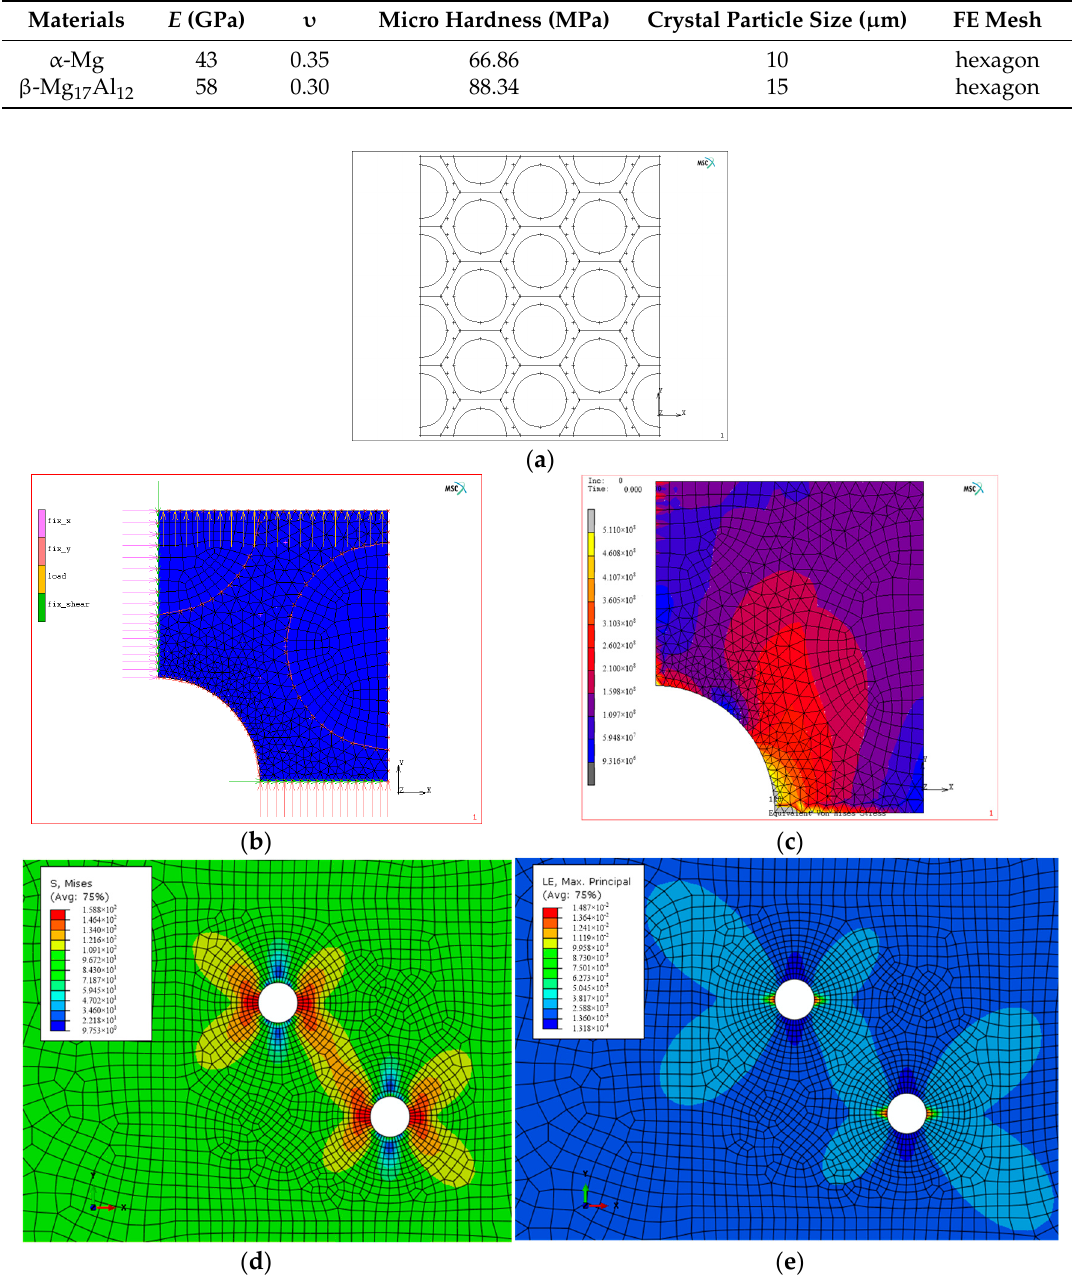
Figure 8. Contour plots of different stresses and plastic strain of cast AM60B alloy. ( a ) FE modeling of cellular texture; ( b ) boundary conditions; ( c ) von Mises stress amplitude distribution (unit: Pa); ( d ) max stress amplitude distribution in one cycle (unit: Pa); ( e ) max plastic strain amplitude distribution in one cycle.